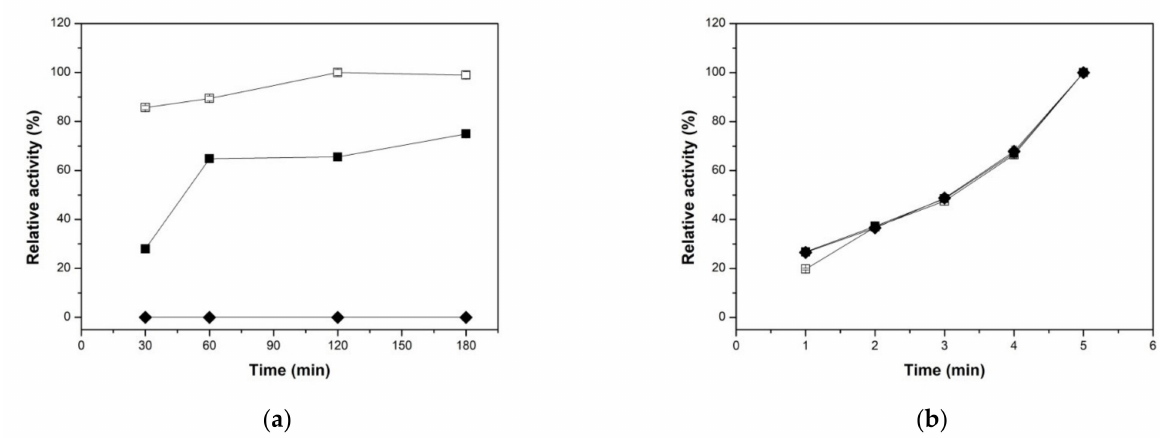
Figure 3. Effect of reaction time on the xylanase ( a ) and β -xylosidase ( b ) activities showed by soluble XynB2 Y509E ( (cid:3) ) and immobilized XynB2 Y509E -CLEAs prepared at pH 8.5( (cid:4) ) or pH 6.5 ( (cid:7) ). Substrate concentrations: Xylan (1%) or p-NPX (2.2 mM). The data points represent the mean values of three replicates with the SE indicated as error-bars. XynB2 Y509E - CLEAs prepared at pH 6.5 or at pH 8.5 displayed the same β -xylosidase activity than that the soluble XynB2 Y509E